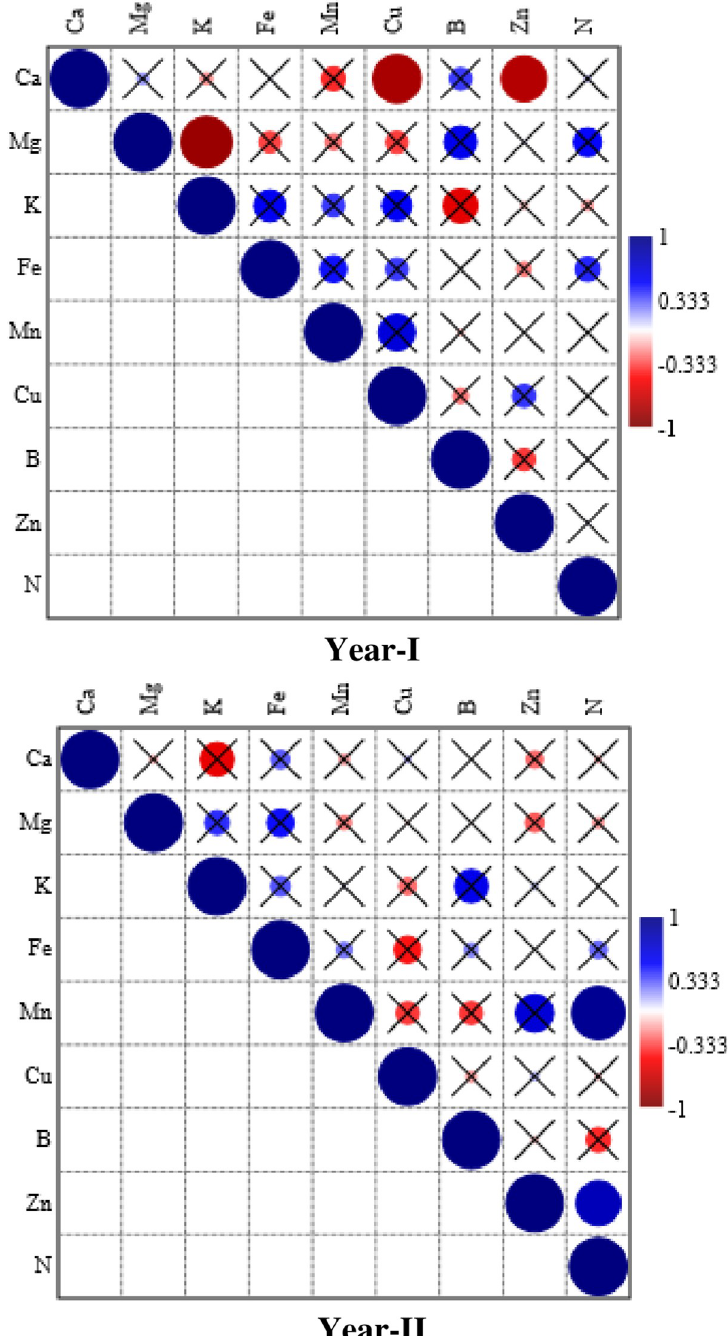
Fig 2. Spearman correlation among different ntrient acquisition traits of graftwed watermelon flesh during both years of the study. The size of the circles indicates strength of the correlation, while checked boxes indicate that the correlation was